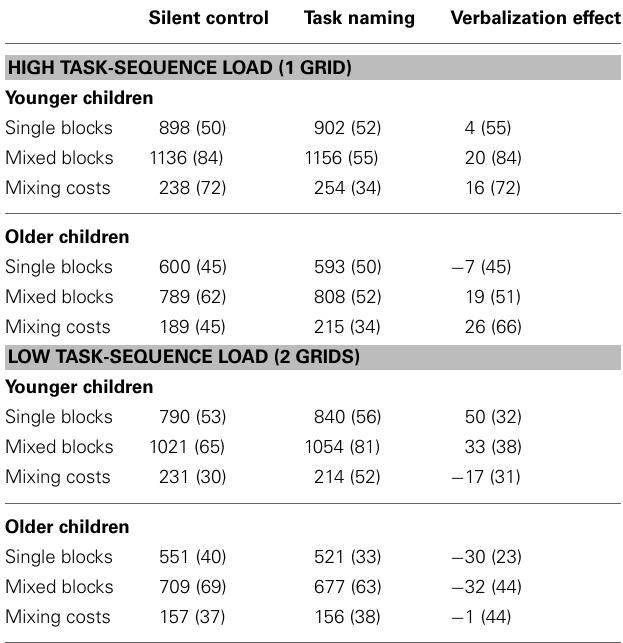
Table 4 | Mean (SE) latencies (ms) as a function of block type (single-task/mixed-task), age group (younger children/older children), task-sequence load (1 grid/2 grids), and verbalization condition (silent control/verbalization for the group without practice in task switching (verbalization condition first).